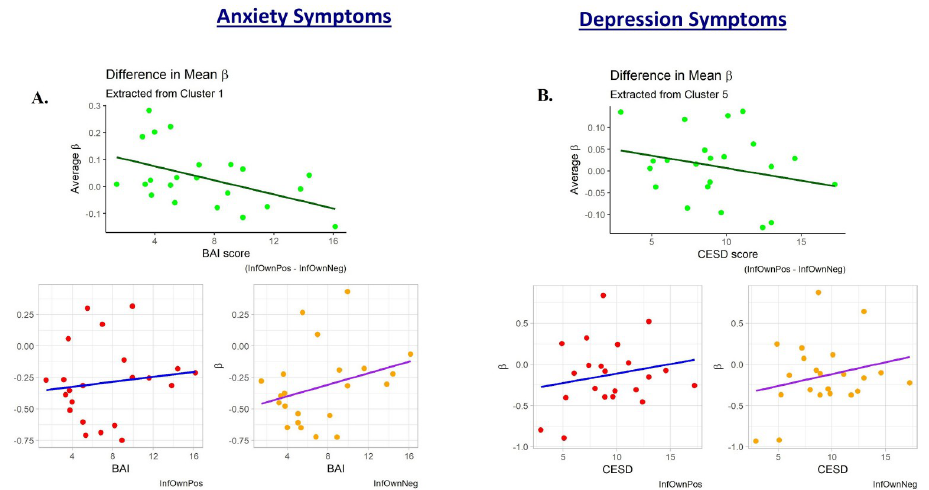
Fig 5. Plots of the subject-level average regression coefficient predicting maternal neural response to own infant positive and negative emotion tasks. One subject with an elevated CESD[T1-T4] and two with elevated BAI[T1-T4] scores appeared to deviate from the general trend of their less symptomatic peers. The plots are displayed with these potential outliers removed. A.) shows these values plotted against participant anxiety scores (BAI). This cluster was defined from the regression against BAI and is a large area covering primarily parietal lobe structures. The upper plot is the difference between these two mean coefficients for each subject and is reflective of the general decreases observed in the whole-brain analysis. B.) shows a similar trend when coefficients are plotted against depression scores (CESD). This cluster was defined from the regression against CESD and is located mostly within the right dorsolateral superior frontal